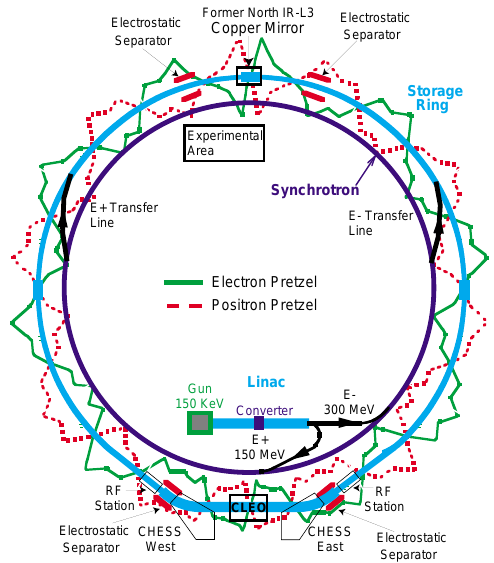
FIG. 1. (Color) The layout of the Cornell accelerator complex. The streak camera experimental area and the mirror used to reflect the light out of the CESR vacuum chamber are located near the former North interaction region (IR).